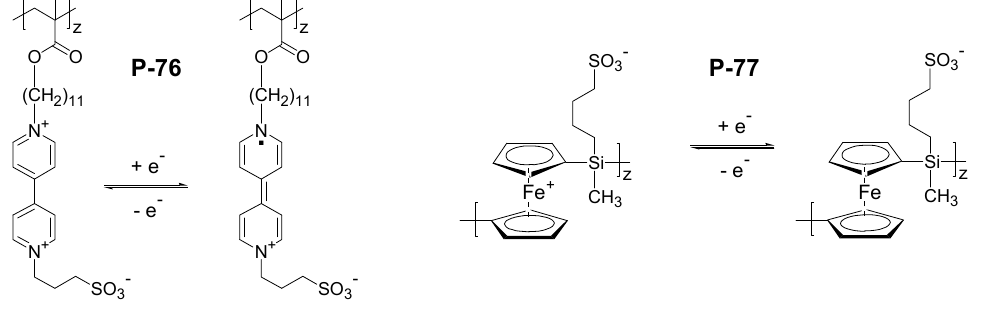
Figure 18. Reversible conversion of polyzwitterions into polyelectrolytes by